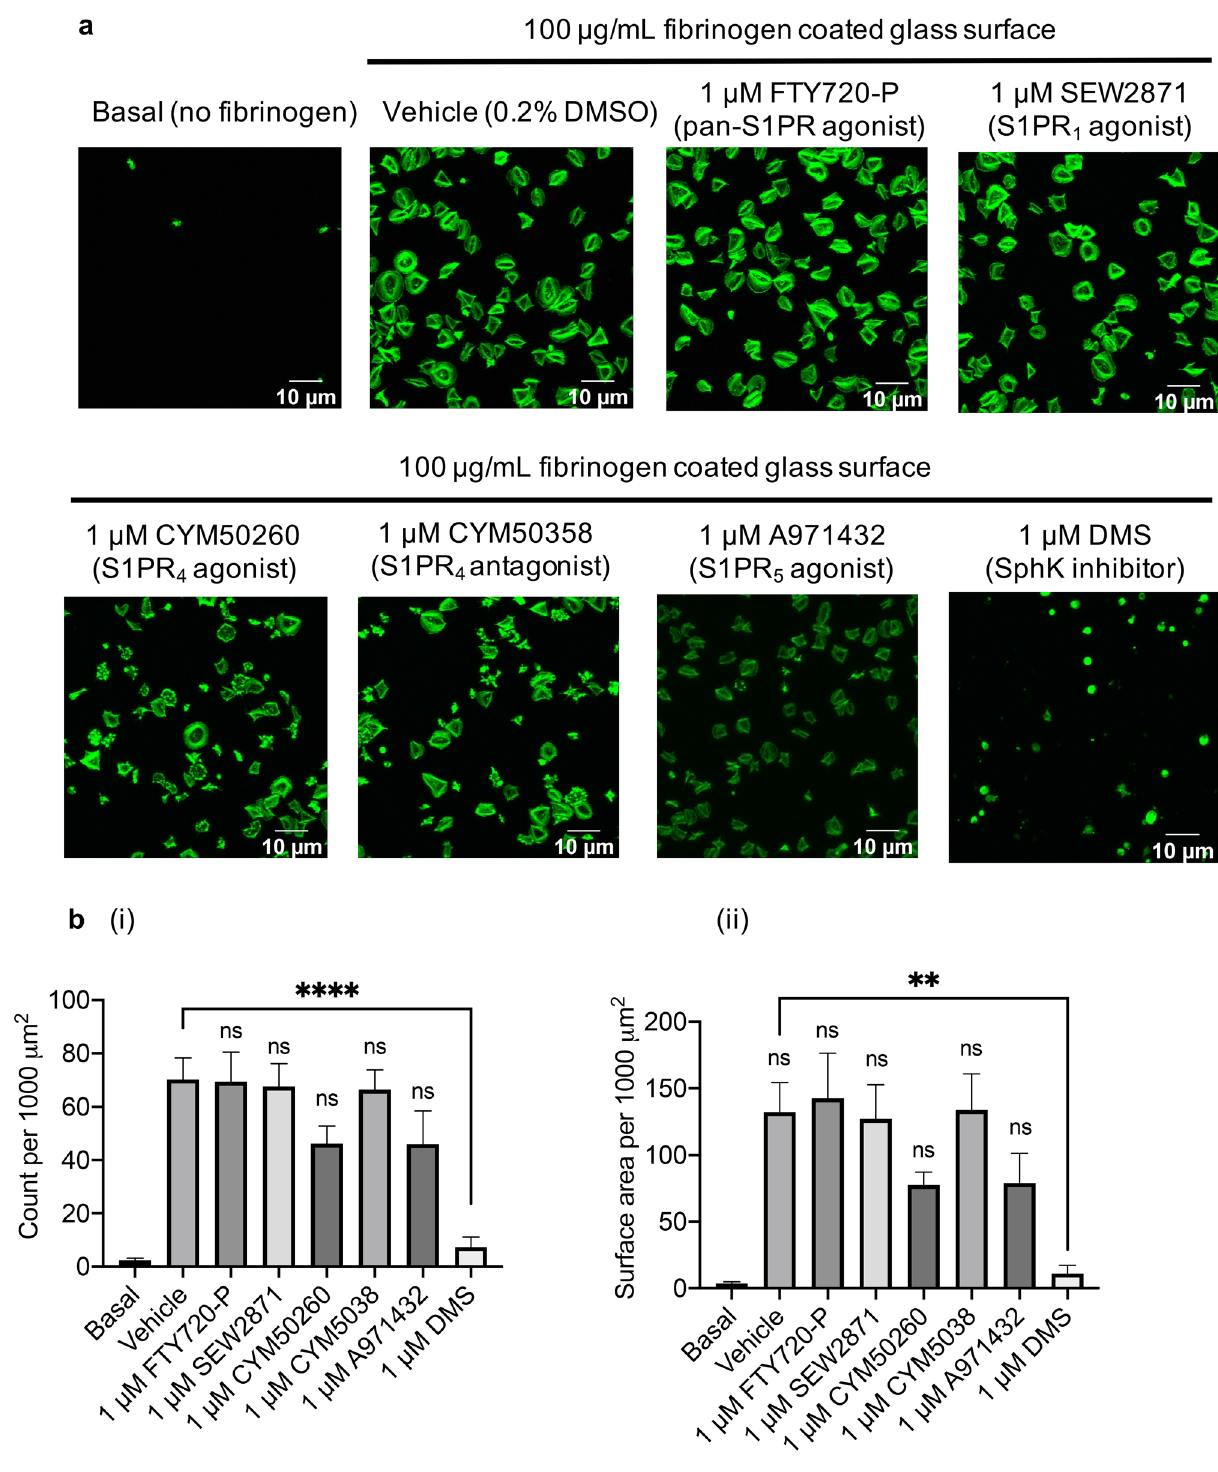
Figure 5. Platelet spreading on fibrinogen is inhibited by S1PR 4 and S1PR 5 agonists and SPHK inhibitor. Washed platelets (2 × 10 7 /mL) were incubated with vehicle control (0.2% methanol), S1P receptor subtype specific agonists or SphK inhibitor DMS for 10 min. Platelets were then left to adhere onto a 13 mm glass coverslip coated with 100 μg/ mL fibrinogen (60 min, 30 °C). Samples were fixed (4% PFA) before permeabilization (0.1% triton) and staining with ActinGreen 488 ReadyProbes reagent. ( a ) Representative images of basal (no fibrinogen), vehicle control, 1 μM FTY720 phosphate, 1 μM SEW2871,1 μM CYM50260, 1 μM CYM50358 hydrochloride, 1 μM A971432, 1 μM DMS. ( b ) Bar graphs of the (i) total number of platelets and (ii) average platelet cell area of platelets adhered in the absence and presence of S1P receptor subtype specific agonists or SphK inhibitor. N = 5. Three images were taken from each well. Average cell area was measured per 1000 μm 2 , data are plotted as mean ± SEM. Statistical analysis: One-way ANOVA with Dunnett’s test. ns = not significant, ** P < 0.01, **** P <